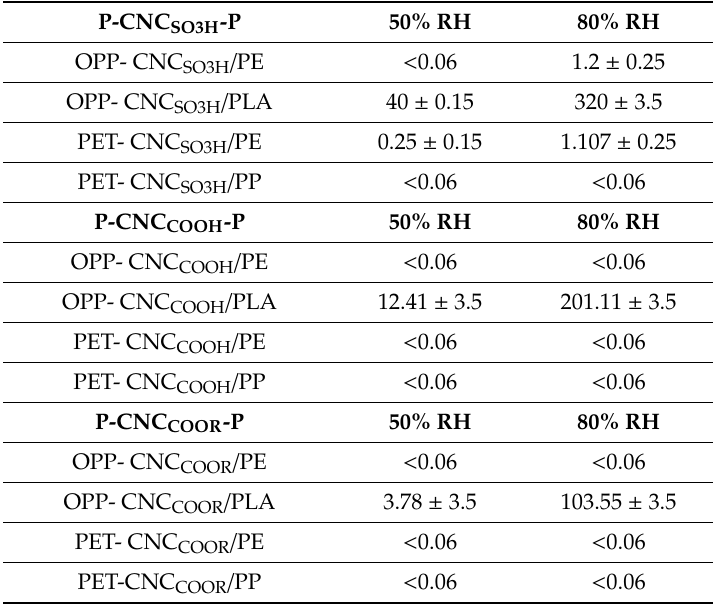
Table 4. Oxygen permeability of laminated coated-polymers at RH 50–80%, calculated from the mean ± standard deviation ( n =